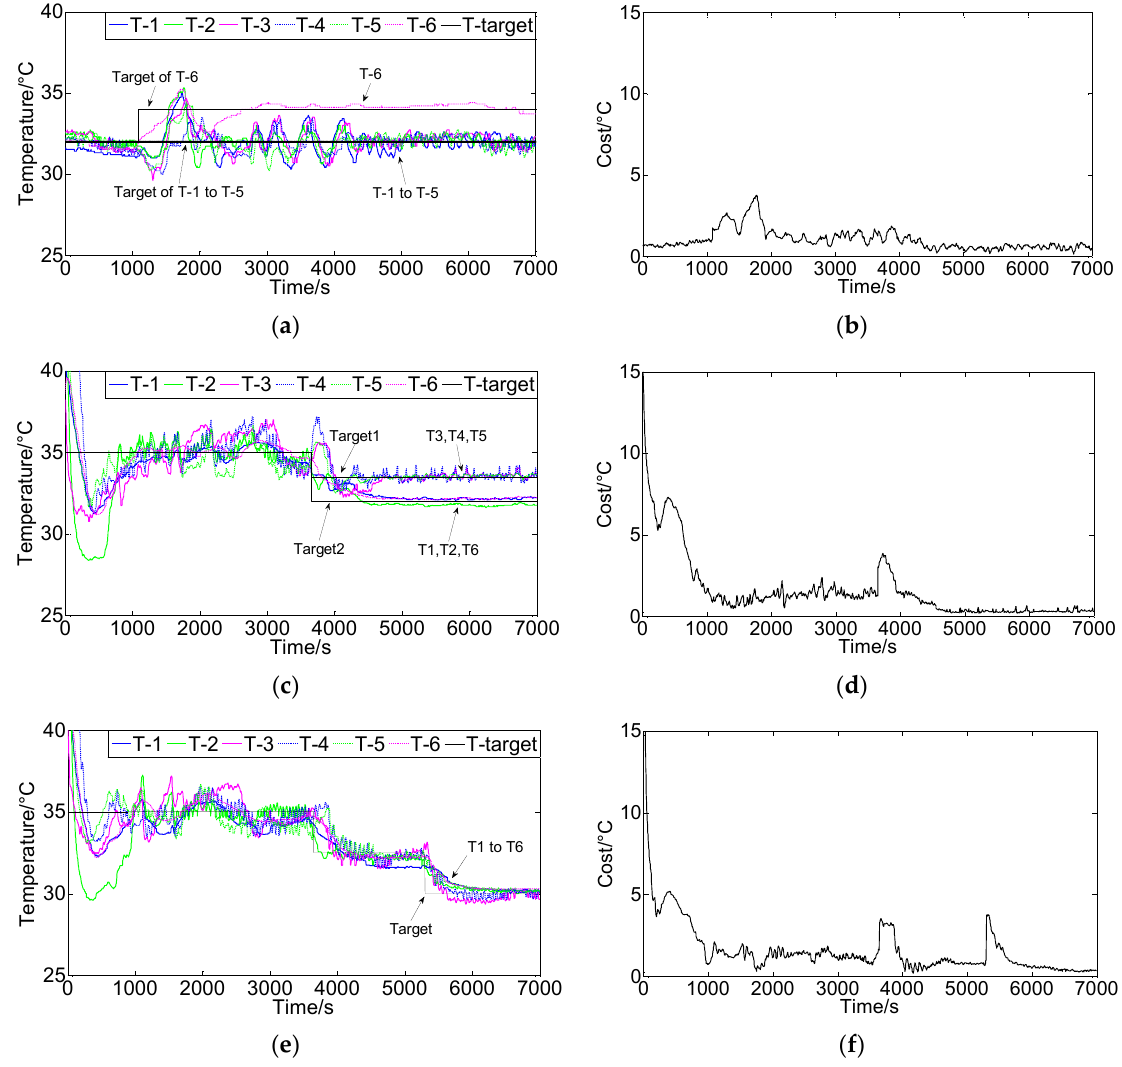
Figure 8. ( a ) Control results of the FCPIDNN controller when one temperature control target changed in a stable state; ( b ) Variation of the square root of the cost function ( J ( n ) ) in process (a); ( c ) Control results of the FCPIDNN controller when temperature control targets changed to two different ones halfway; ( d ) Variation of the square root of the cost function ( J ( n ) ) in process (c); ( e ) Control results of the FCPIDNN controller when temperature control targets changed twice in the control process; ( f ) Variation of the square root of the cost function ( J(n)) in process (e).